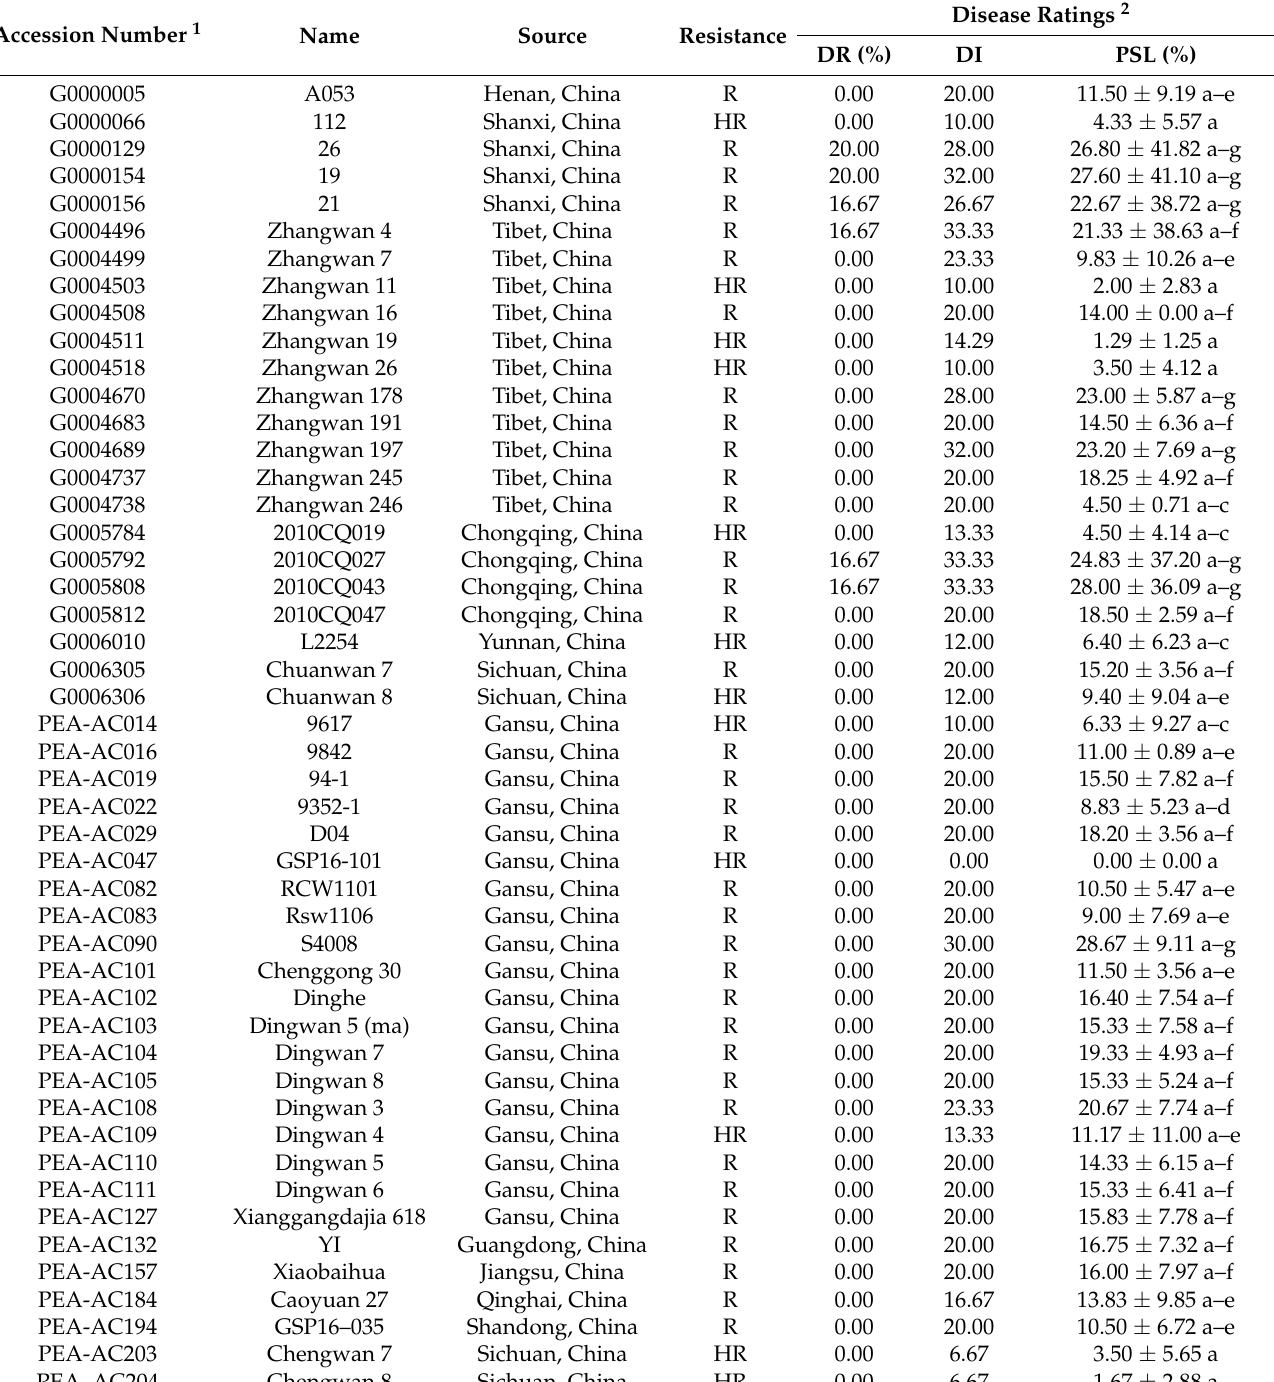
Table 3. Disease ratings of pea resistant accessions in China to Fusarium oxysporum f. sp. pisi race